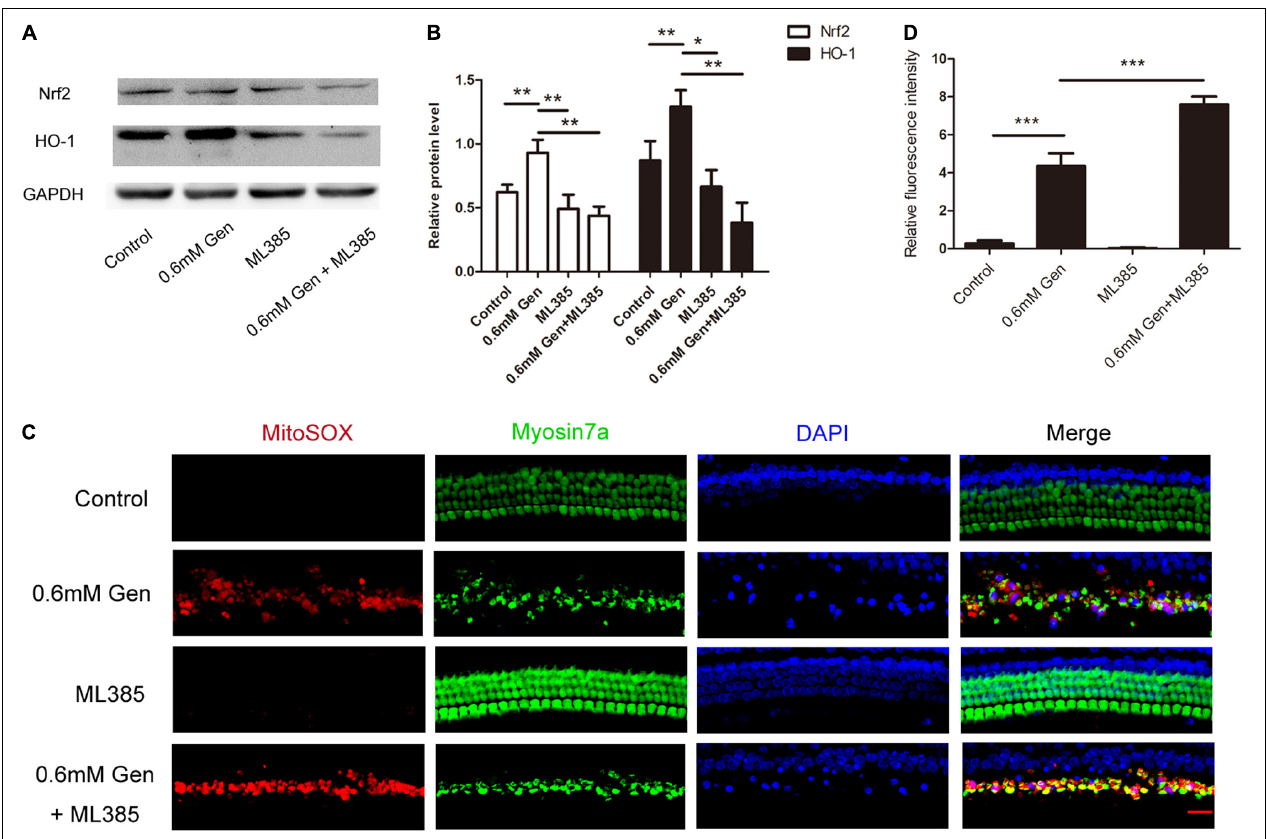
FIGURE 6 | Gentamicin induced heme oxygenase-1 (HO-1) activation via Nrf2 signaling. (A) The level of Nrf2 and HO-1 expression was determined by Western blot in different groups at 24 h after culture. (B) The signal of Nrf2 and HO-1 [from (A) ] quantitated after normalization to β - actin and represented in bar diagrams (* P < 0.05, ** P < 0.01, *** P < 0.001, n = 4). (C) Representative micrographs showing MitoSOX Red immunostaining in different groups. (D) Quantification of relative fluorescence intensities of reactive oxygen species (ROS) in each group (*** P < 0.001, n =